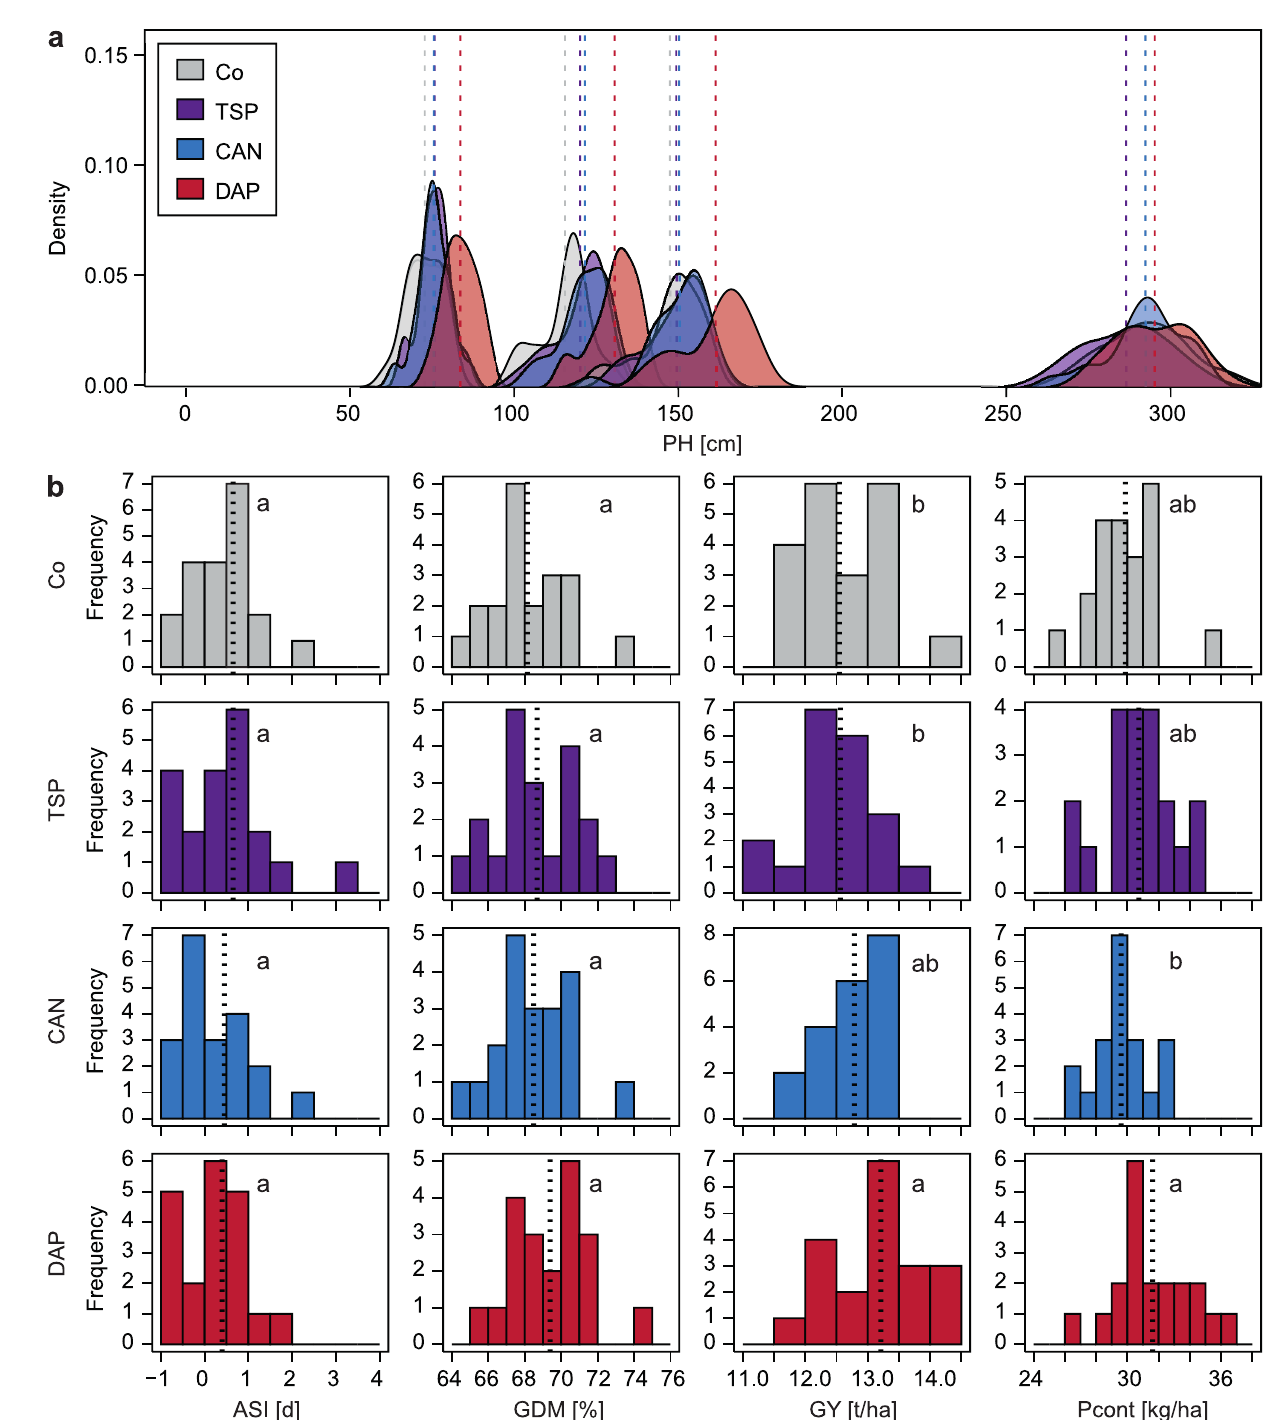
Fig 1. Response of different traits to starter fertilizers. Control (Co, grey), triple superphosphate (TSP, purple), calcium ammonium nitrate (CAN, blue), diammonium phosphate (DAP, red). (a) Density plots of plant height distributions at four different time points (PH1, PH2, PH3, PHfinal). (b) Histograms of anthesis-silking-interval (ASI), grain dry matter (GDM), grain yield (GY), and P content (Pcont). Different letters indicate significant (p- value < 0.05) differences between starter fertilizer means.